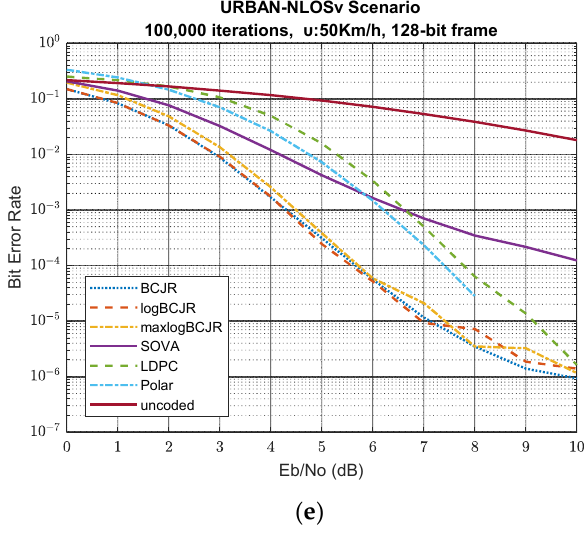
Figure 2. BER vs. SNR for scenarios 1 - 5 and frame length 128 bits. ( a ) Highway - LOS scenario; ( b ) highway - NLOSv scenario; ( c ) urban - LOS scenario; ( d ) urban - NLOS scenario; ( e ) urban - NLOSv scenario.